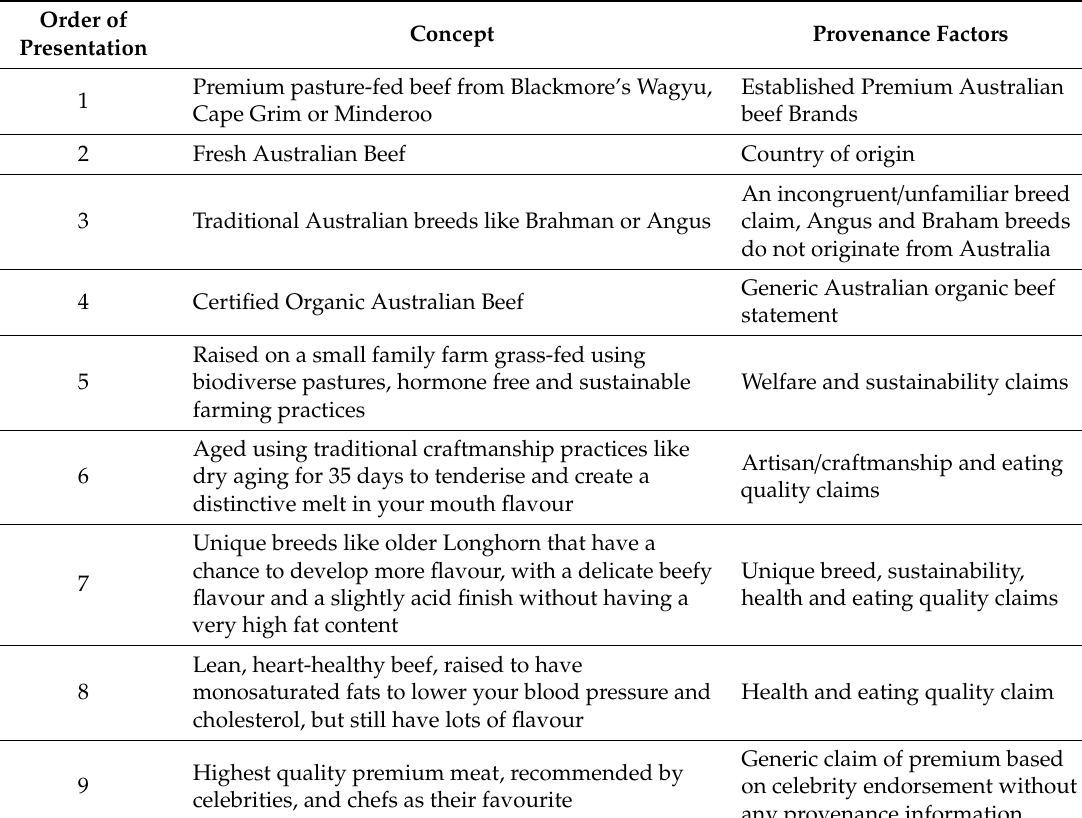
Table 1. Beef concepts, presentation order and their associated provenance